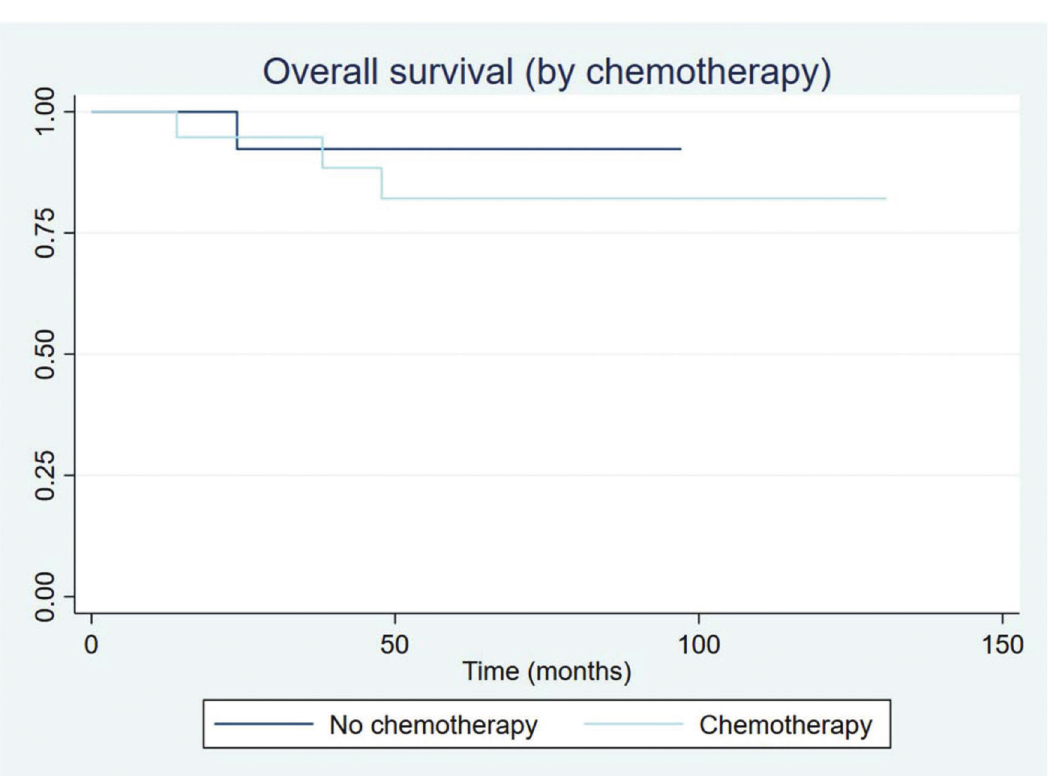
Fig 6 - Overall survival by chemotherapy group.